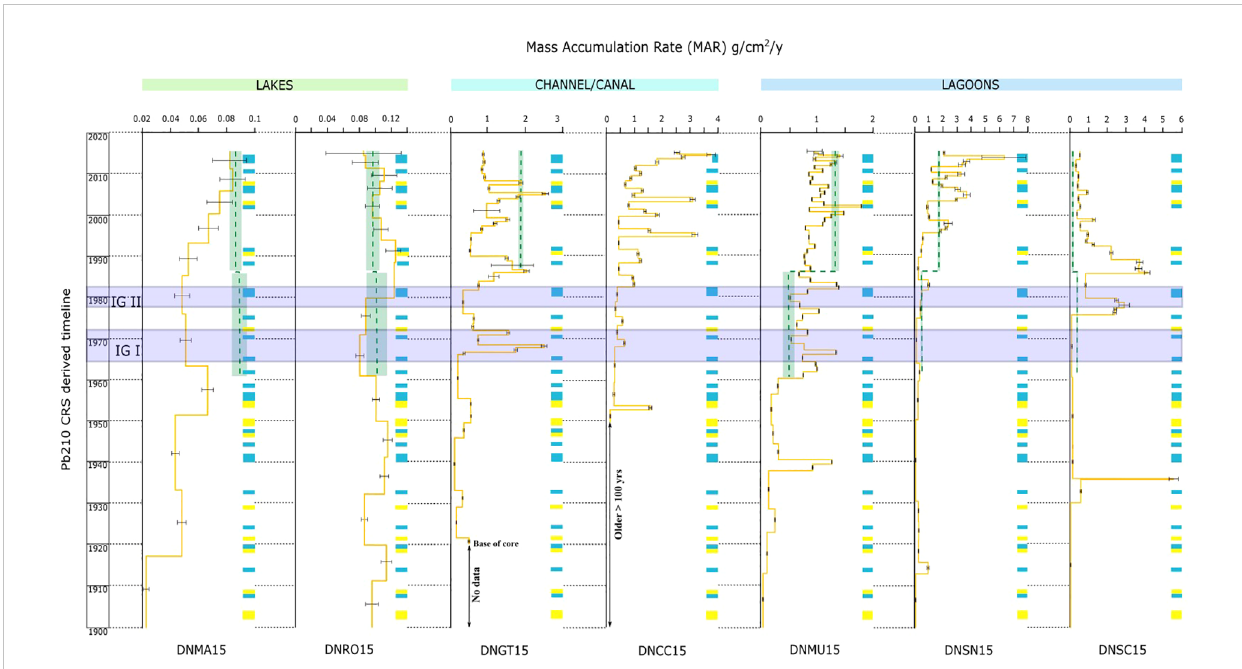
FIGURE 6 Mass accumulation rates in g/cm 2 /y for lakes, channels and lagoons of the Danube Delta, based on the time line obtained from 210 Pb dating (orange line), using the CRS (Constant Rate of Supply) model and 137 Cs (green line). The input of dams on the time line (Iron Gate I – 1964-1972 and Iron Gate II – 1978-1982) is marked by the purple squares. The blue and yellow squares mark major fl oods (1907, 1914, 1919, 1924, 1932, 1940-1941, 1944, 1947, 1954-1956, 1958, 1962, 1965, 1970, 1975, 1980-1981, 1988, 1991, 2002, 2005-2006, 2010, 2013-2014) and hydrological drought